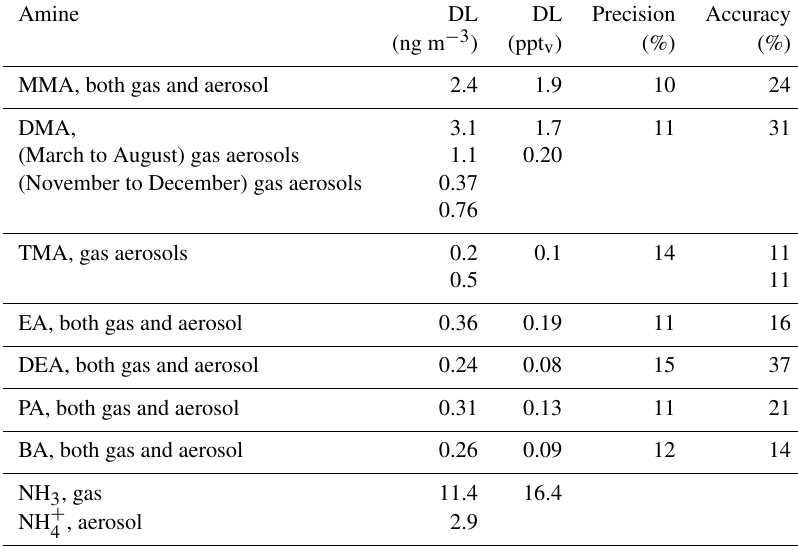
Table 1. DLs of different amines, ammonia, and ammonium. Conversions from ngm − 3 to ppt v have been made using the conversion